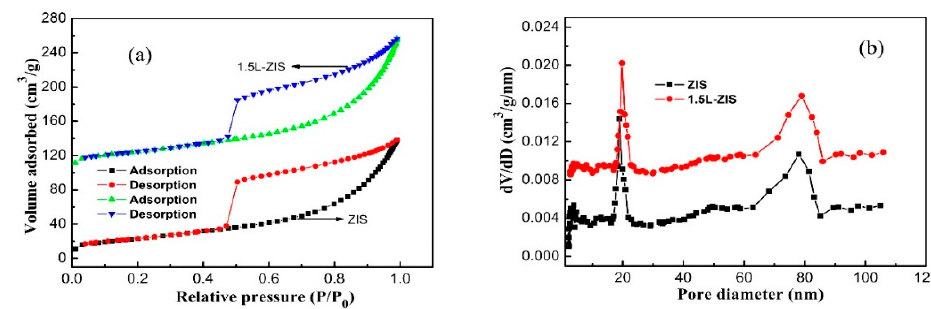
Figure 6. ( a ) Nitrogen adsorption–desorption isotherm; ( b ) corresponding pore size and distribution of the 1.5L-ZIS